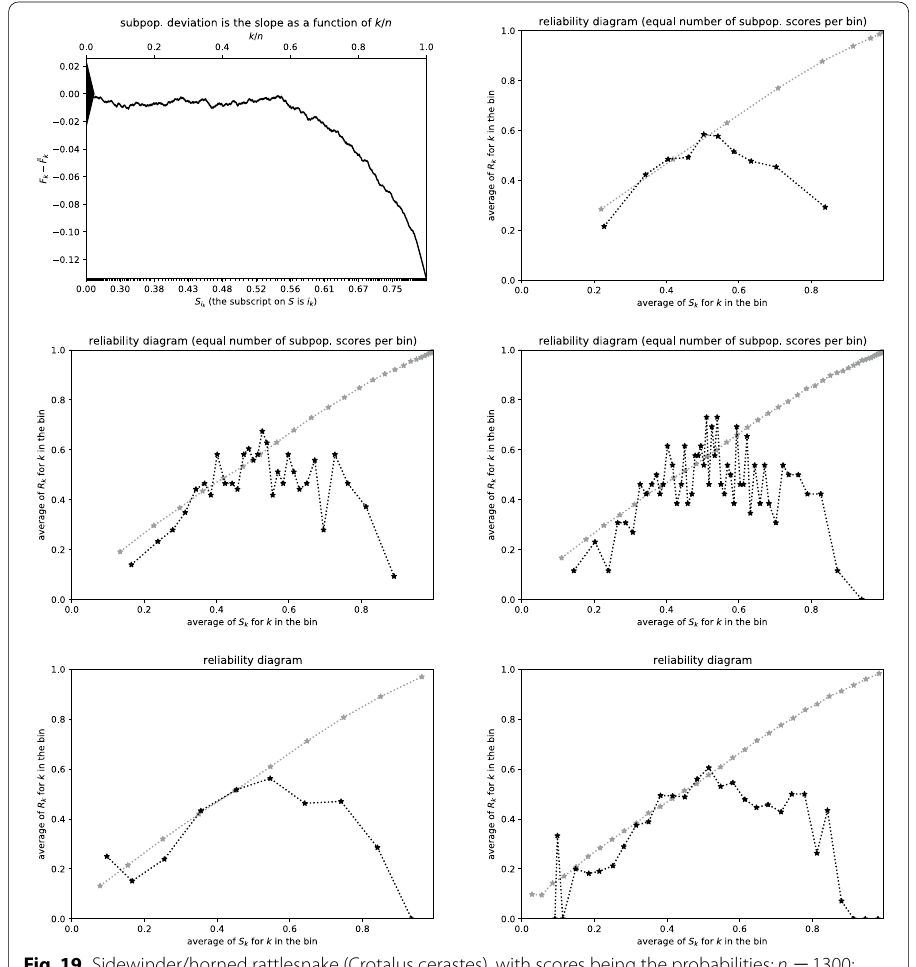
Kuiper’s statistic is 0.1343 /σ = 10.47 , Kolmogorov’s and Smirnov’s is 0.1340 /σ = 10.45 . As in Figure